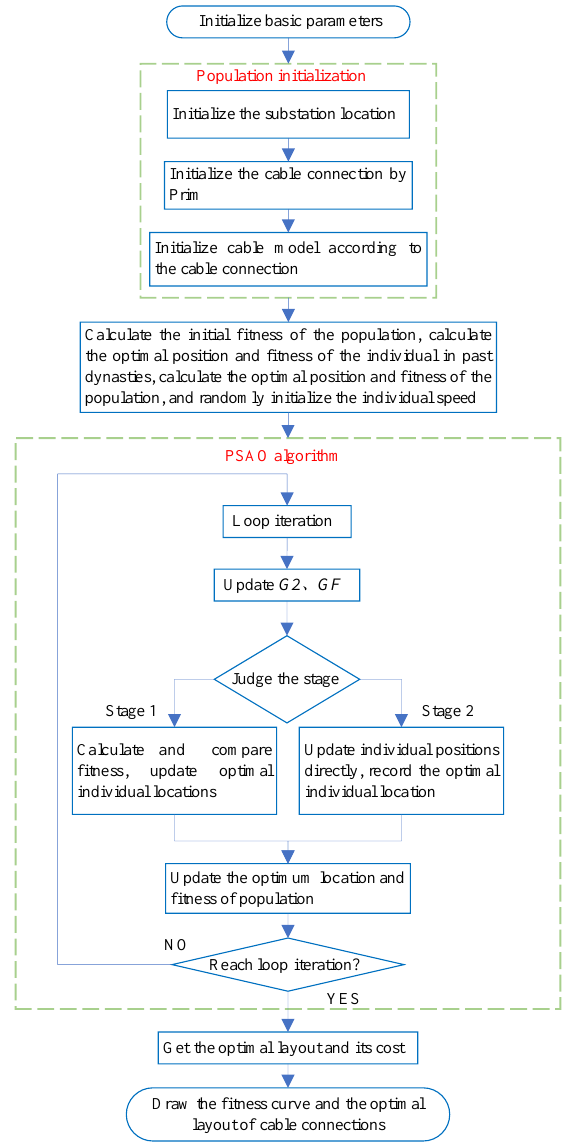
Figure 4. The process of our